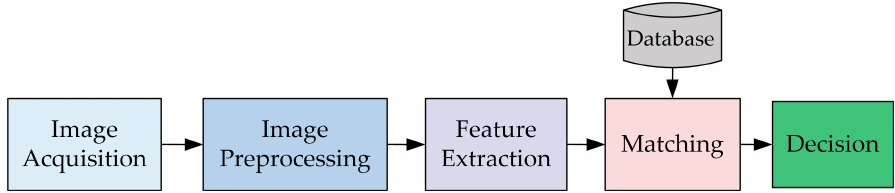
Figure 1. The architecture of the biometric recognition